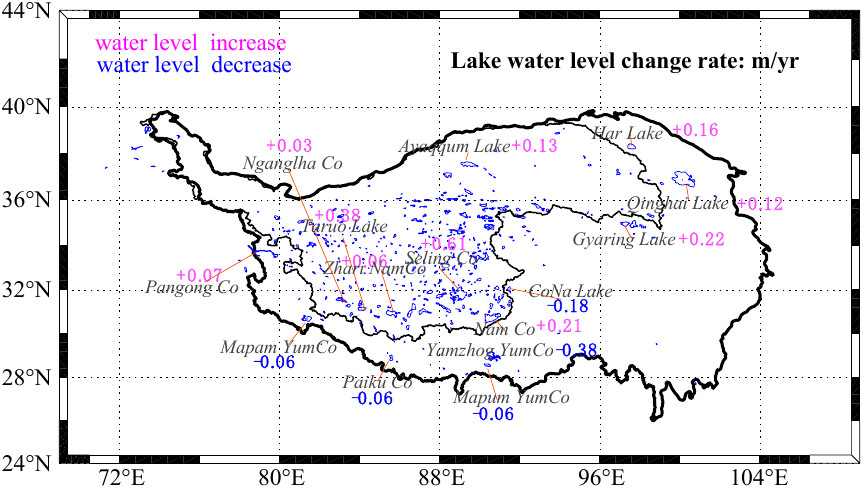
Figure 12. Rates of water level changes in 15 major lakes over the period from March 2003 to October 2009 estimated from ICESat data are shown as numbers along lakes (m/yr). Red numbers represent the water level of lakes that increased, and blue numbers represent the water level of lakes that decreased during the investigated period. The black line across Tibet separates basins of endorheic from exoreic rivers.